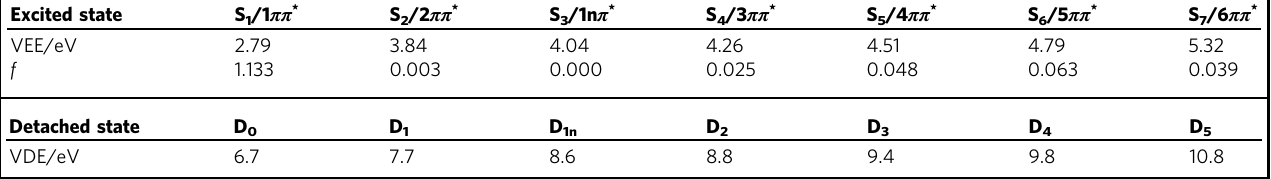
Table 2 XMCQDPT2/EFP calculated vertical excitation energies (VEEs) and oscillator strengths ( f ) of p -HBDI − in aqueous solution. The lowest-lying doublet states, D 0 and D 1 , are calculated for a system embedded in a water sphere with R = 40 Å, using the hybrid DFT/EFP/MD equilibrium geometry shown in the Supplementary Methods, at the XMCQDPT2/EFP level of theory. The higher-lying vertical detachment energies (VDEs) are estimated with respect to D 0 at the minimum energy geometry of the